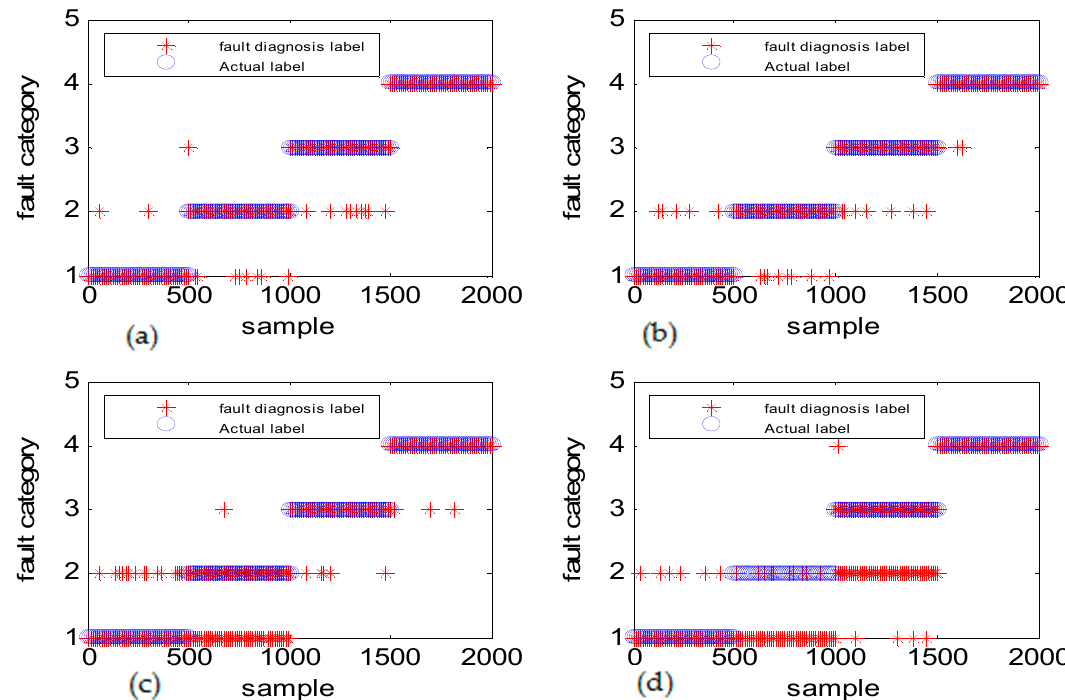
Figure 20. Benchmark test for the diagnosis of different fault types with the same size: ( a ) DGFFDNN, ( b ) DNN, ( c ) DGFFBP, and ( d ) BP. The number of samples used in the experiment was 487,384. To visualize the classification results, only part of the experimental results were displayed. The experiment used a normal dataset and three fault datasets. The three sets of fault data were the cases where the inner ring fault sizes were 0.007 inches, 0.014 inches, and 0.021 inches, respectively, when the load was 3 hp.